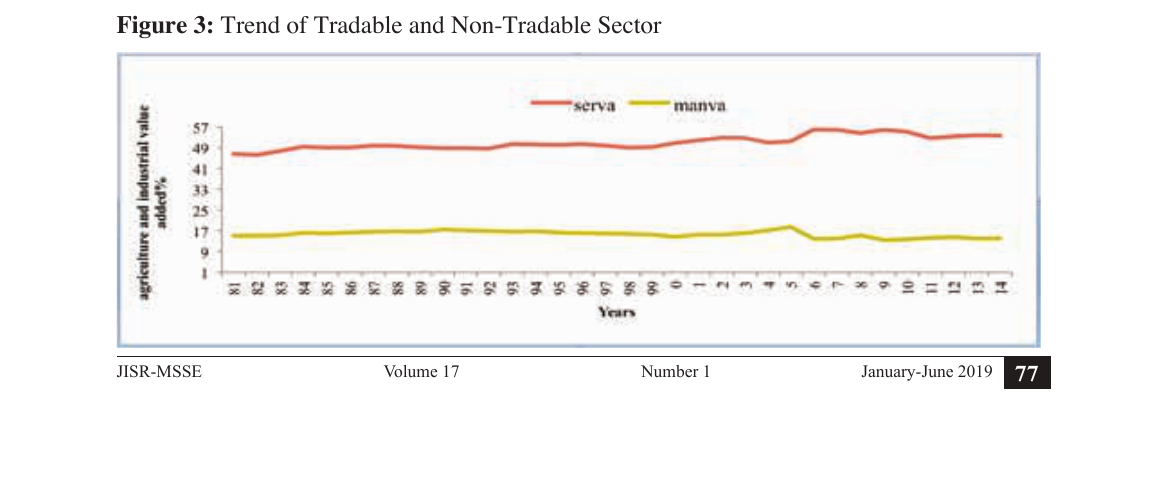
Figure 3: Trend of Tradable and Non-Tradable